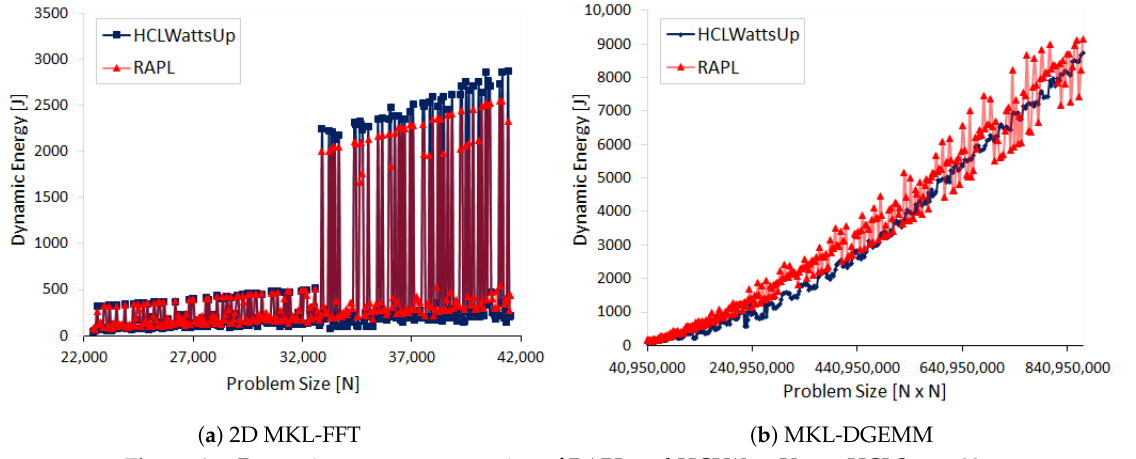
Figure A4. Dynamic energy consumption of RAPL and HCLWattsUp on